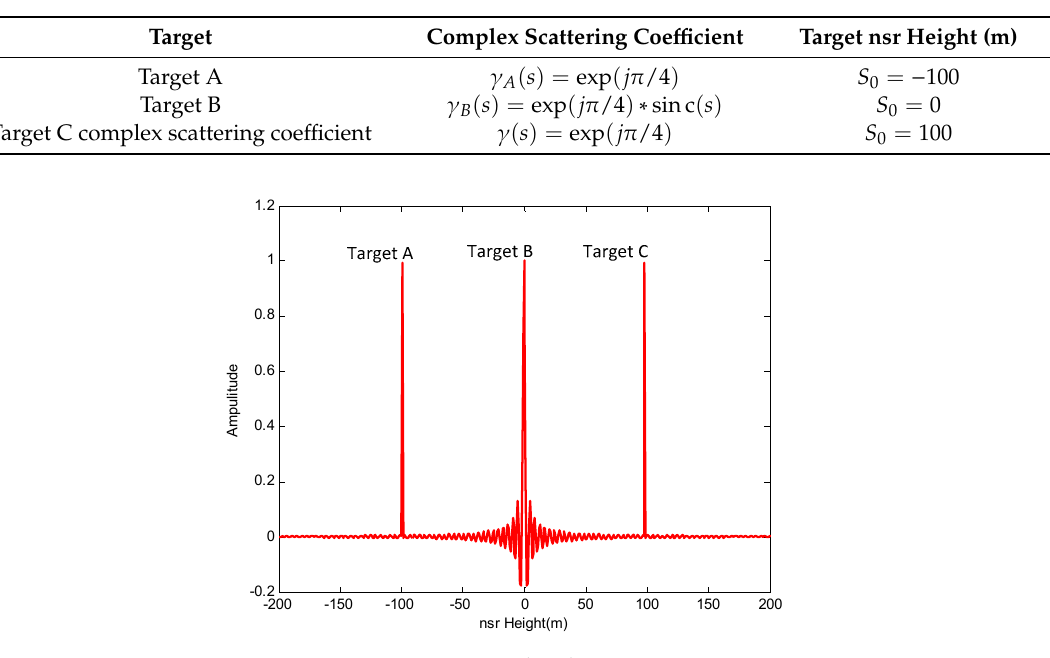
Table 5. Target information.